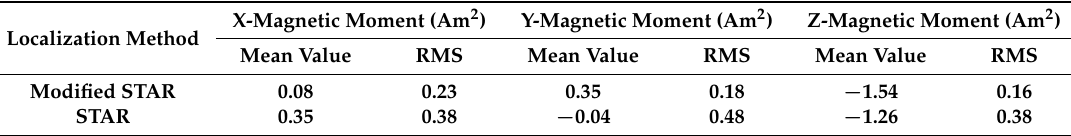
Figure 10. The estimated Z-magnetic moment of test specimen. Table 4. The Mean Value and RMS Error of the Estimated Magnetic